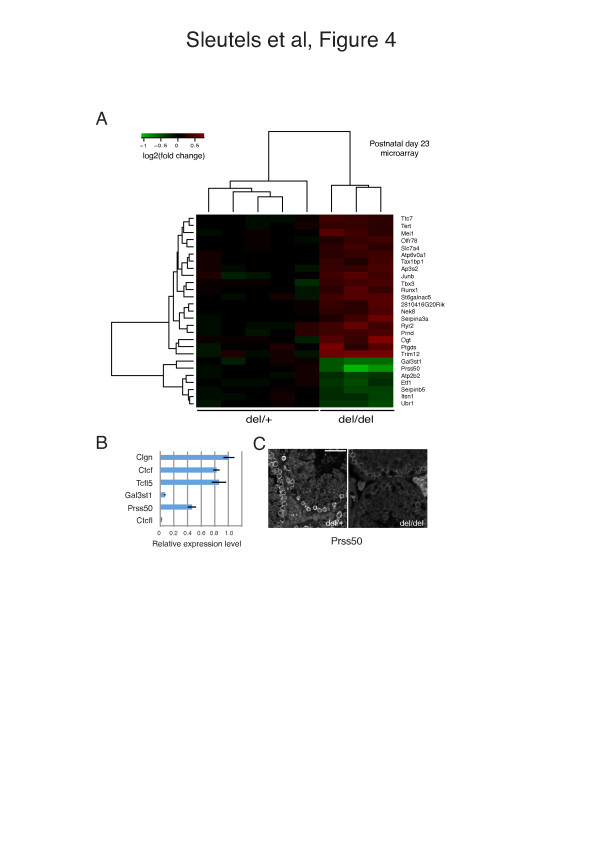
Regulation of testis-specific genes by CTCFL. A Heatmap representation of microarray data. We compared five samples from heterozygous and three samples from homozygous Ctcfl knockout mice. Depicted are the top 27 deregulated genes, where the log2-transformed fold change compared to the average expression in heterozygous testis is shown. B Expression analyses in Ctcfl mutant testes. Real-time RTPCR expression analyses on testis RNA from Ctcfl mutant mice relative to wild type using Ccna1 as reference. Genes were examined in 90-day-old testes. C Reduced PRSS50 expression in Ctcfl mutant testis. Immunofluorescence analysis of testis sections from heterozygous (del/+) and homozygous (del/del) Ctcfl knockout mice, using antibodies against PRSS50.